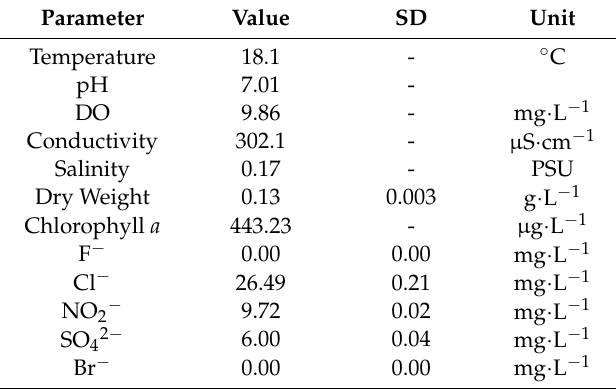
Table 1. Detailed physicochemical characterization of water retention pond (WRP) during a bloom event (19th May 2014).